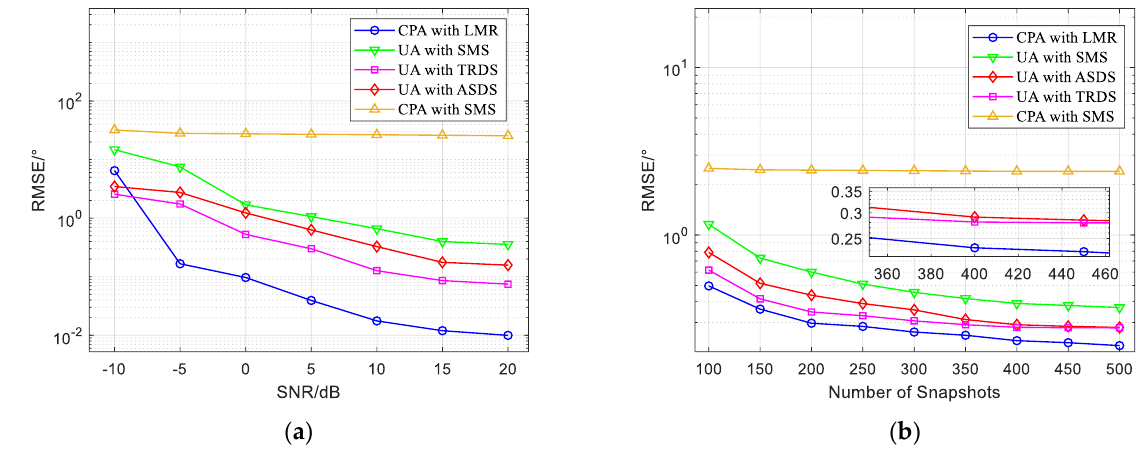
Figure 6. RMSE versus SNR and number of snapshots for different algorithms. ( a ) RMSE versus SNR for different algorithms; ( b ) RMSE versus number of snapshots for different algorithms.